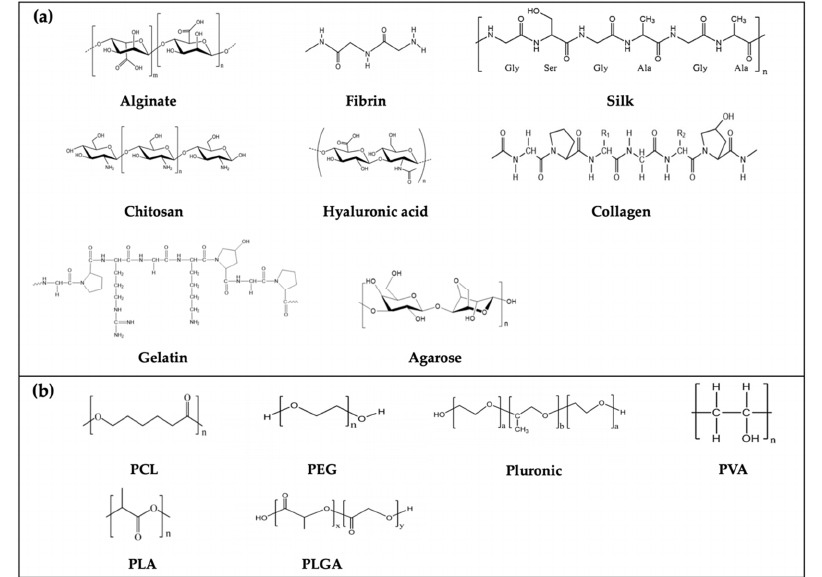
Figure 3. Chemical structure of ( a ) nature and ( b ) synthetic polymers. The chemical structure of alginate, fibrin, chitosan, hyaluronic acid, polyethylene glycol (PEG), polylactic-co-glycolic acid (PLGA) and pluronic were adapted with permission from [129]. Copyright 2017 Elsevier; silk and polyvinyl alcohol (PVA) were adapted with permission from [130]. Copyright 2017 Elsevier; polycaprolactone (PCL) and polylactic acid (PLA) [131]; agarose and gelatin [132]; collagen [133].